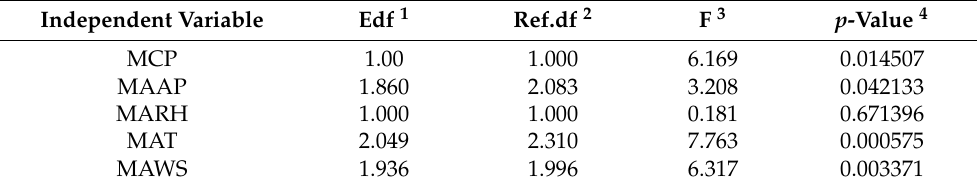
Table 4. Statistical characteristics of variables and GAM fitting results.